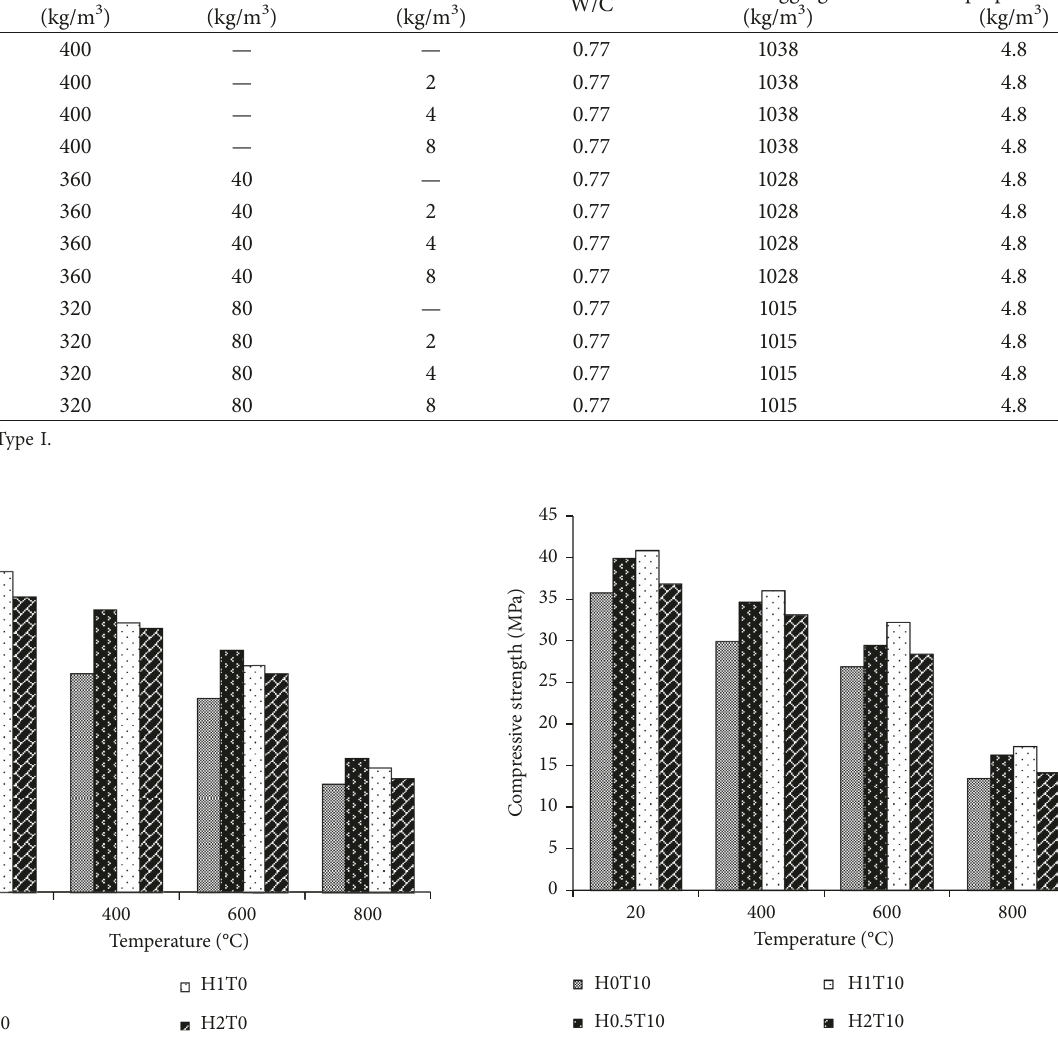
Figure 1: Compressive strength results for carbon fiber-reinforced lightweight concrete without silica fume.